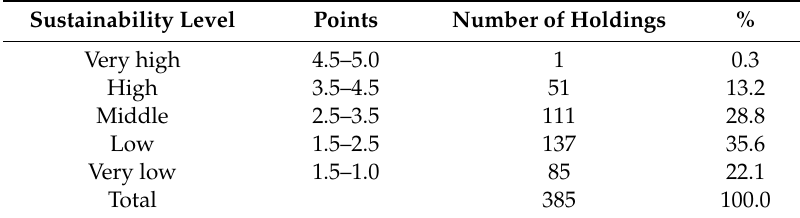
Table 2. Level of holdings’ sustainability.